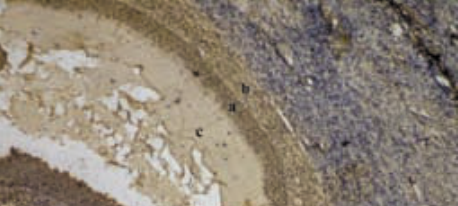
(a) primordial follicles (b) primary follicles, (c) small antral follicle, (d) large antral follicle, (e) germinal epithelium